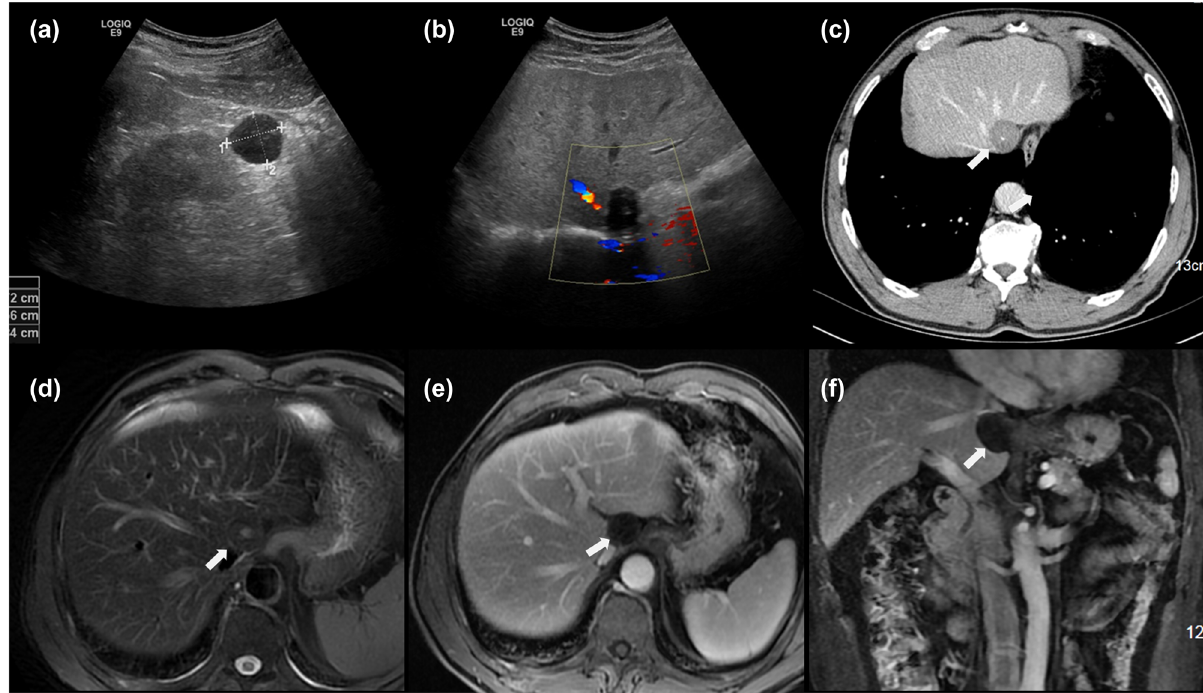
Figure 1: Doppler echocardiogram images ( a and b ) show a hypoechoic mass at the edge of the hepatic caudate lobe and no obvious blood fl ow signal in the mass. Contrast - enhanced venous phase CT image of the abdomen ( c ) reveals a concentric round, well - de fi ned none - nhanced mass ( arrow ) with central calci fi cation. Fat - suppressed T2 - weighted images and gadolinium - enhanced fat - suppressed T1 - weighted MR images ( d – f ) show a hypointense mass as muscle tissue without any enhancement ( arrow ) .